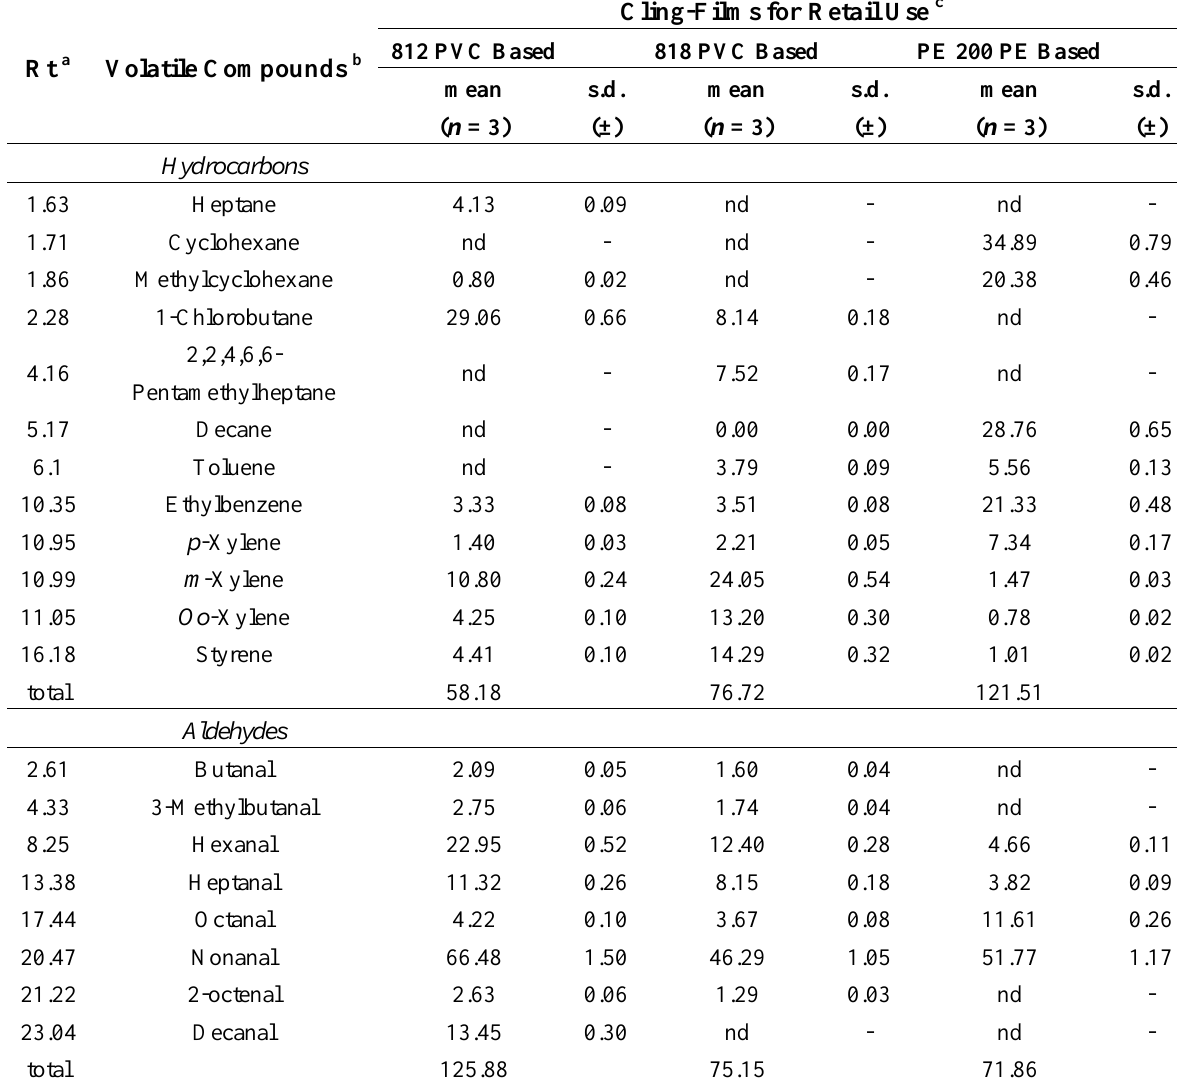
Table 1. VOC profile by HS-SPME-GC/MS of cling-films for retail